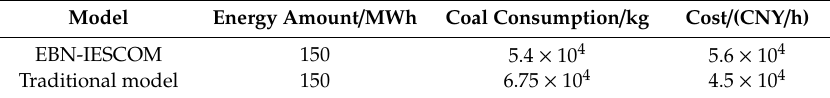
Table 12. Simulation results of energy consumption and cost in ESCO10.